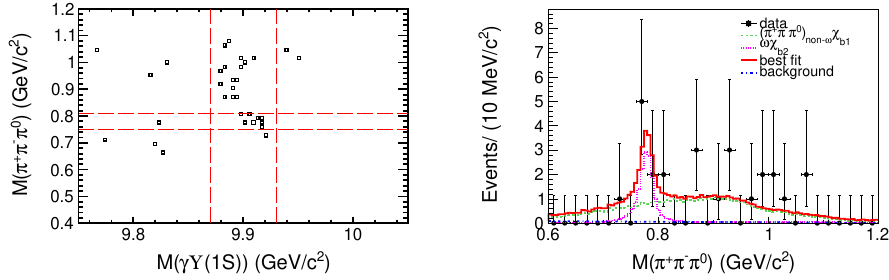
Figure 3. (Left) A scatter plot of M ( π + π − π 0 ) versus M ( γ Υ (1 S )) from data. Red dashed lines indicate signal regions of the χ bJ (1 P ) and ω . (Right) The projections of the 2D fit for events in the χ bJ signal region. Points with error bars are data, solid lines are the best fit, dashed lines are the χ b 1 signals, dotted lines are χ b 2 signals, and the dash-dotted lines are the fitted